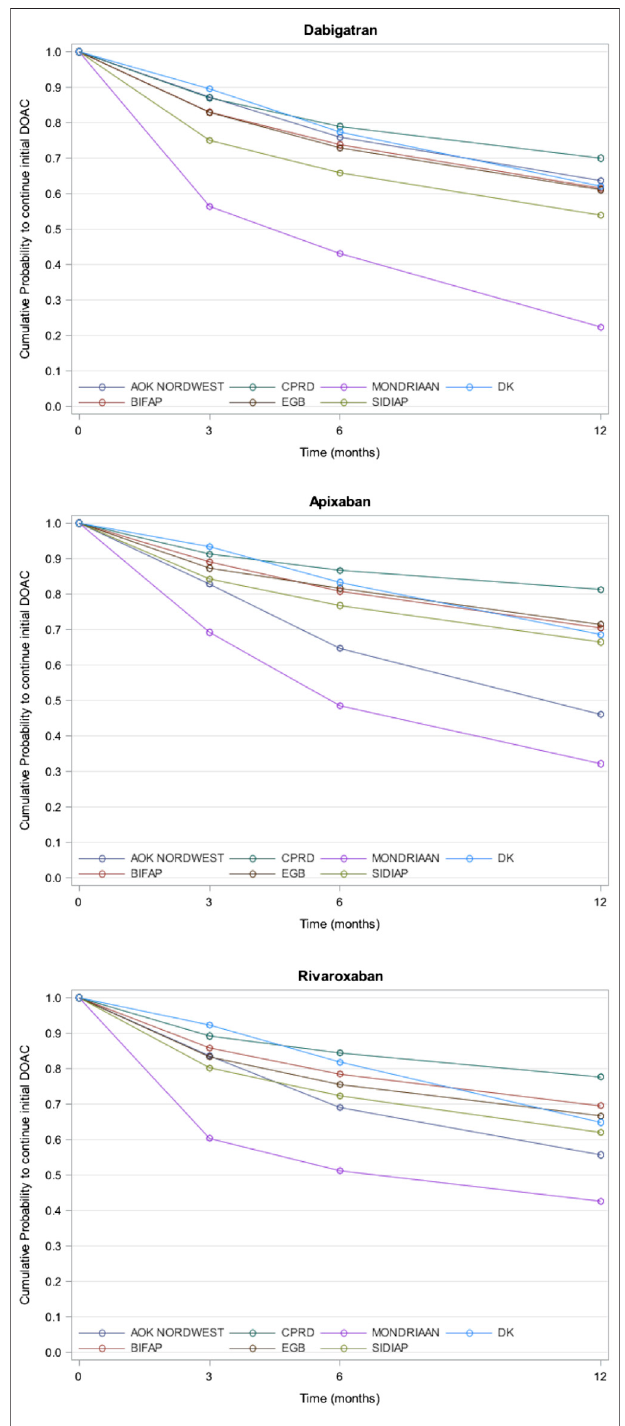
FIGURE 1 | Probability of Continuation of individual DOAC in each